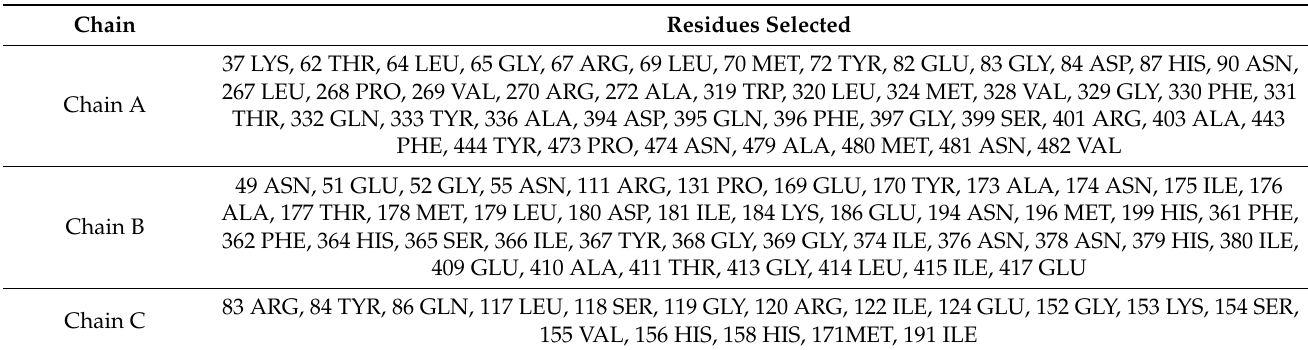
Table 3. Docking results of the compounds against Methyl Coenzyme M.